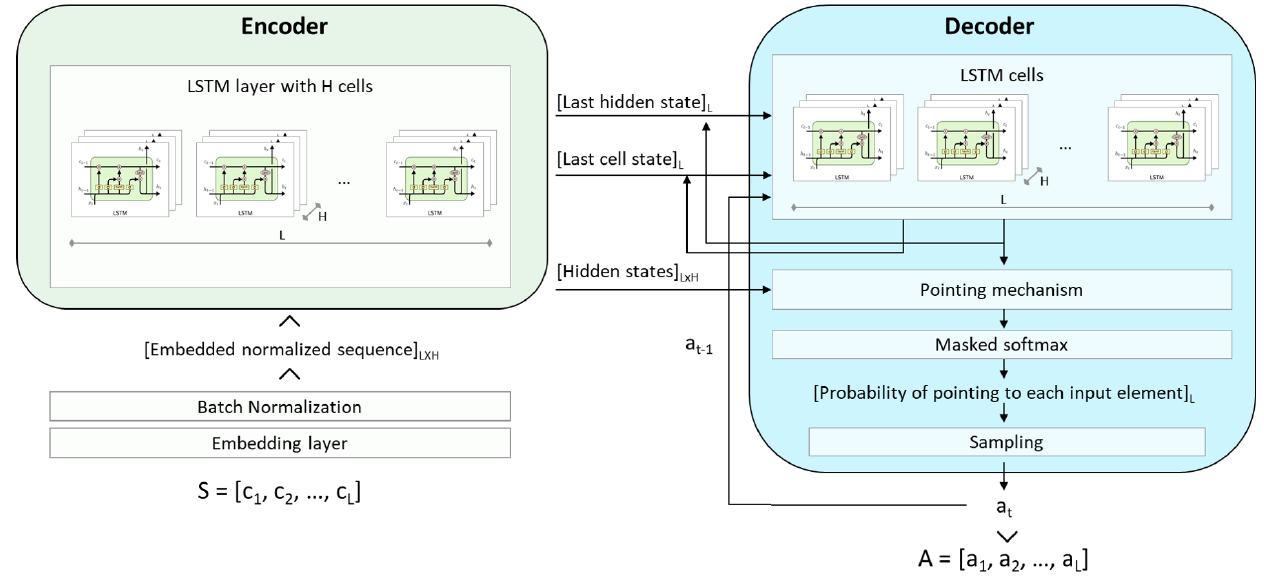
Figure 8. Neural network architecture. The encoder reads the input sequence S = [ c 1 , . . . , c L ] of task costs and ultimately produces an allocation order sequence A , which can be defined as numbers “pointing” at positions in the input sequence S